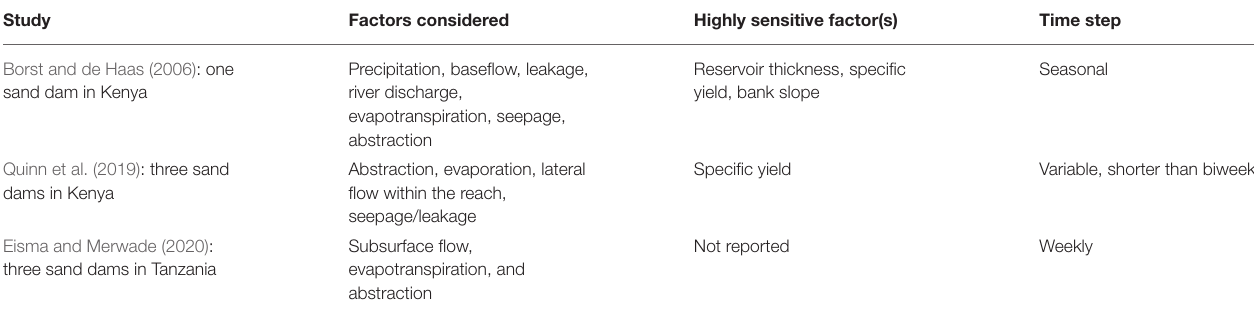
TABLE 1 | Published sand dam water balances. Study Factors considered Highly sensitive factor(s) Time